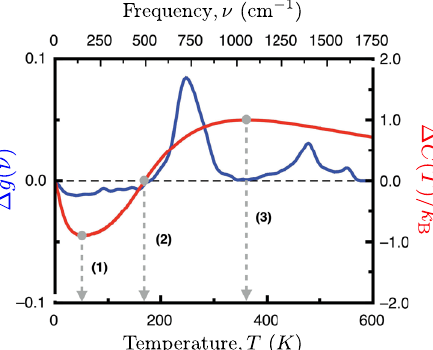
Fig. 6 Thermodynamical implications of the pentagonal facets in the fullerene family. Temperature-dependent difference of the heat capacities (red curve) between the C 720 fullerene and graphene, Eq. (3), scaled by 10 3 (the right side is its corresponding y -axis). The blue curve corresponds to the cumulative value of the difference between their VDOSs as a function of the frequency, Eq. (4) (the left side is its corresponding y -axis). The dashed vertical lines indicate relevant temperature values: (1) 54 K, graphene ’ s heat capacity reaches its maximum value relative to the C 720 ’ s one; (2) 170 K, equality of heat capacities; (3) 362 K, C 720 ’ s heat capacity reaches its maximum value relative to graphene ’ s